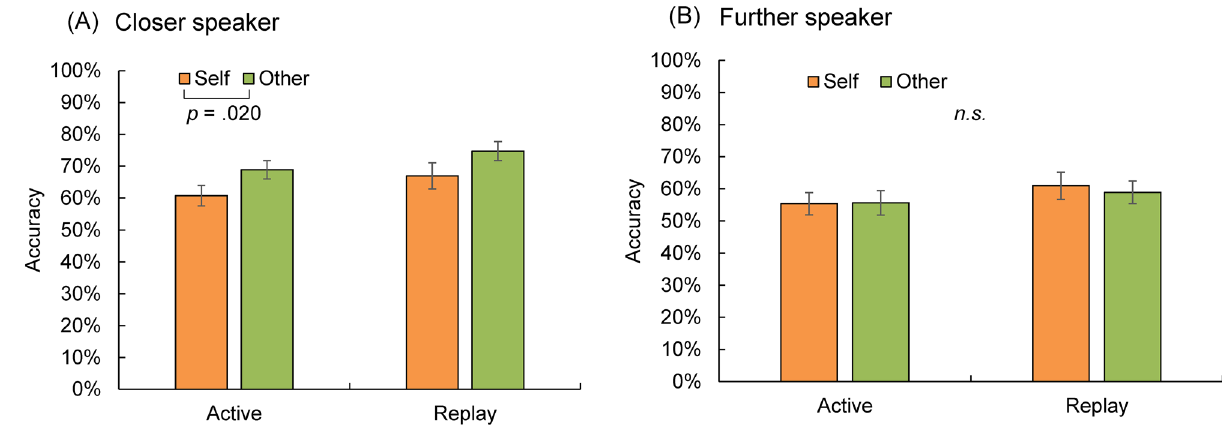
Figure 4. Distance judgment accuracy for the voice stimuli that were presented from the closer speakers (i.e., 90 cm) and those further away (i.e., 180 cm). The effect of type of voice (self vs. other) was significant for the closer speakers but non-significant for the speakers further away. This indicated that participants tended to overestimate the distance for the self-voice instead of just making a poorer spatial judgment for the self-voice compared to that for the other-voice. Error bars represent standard